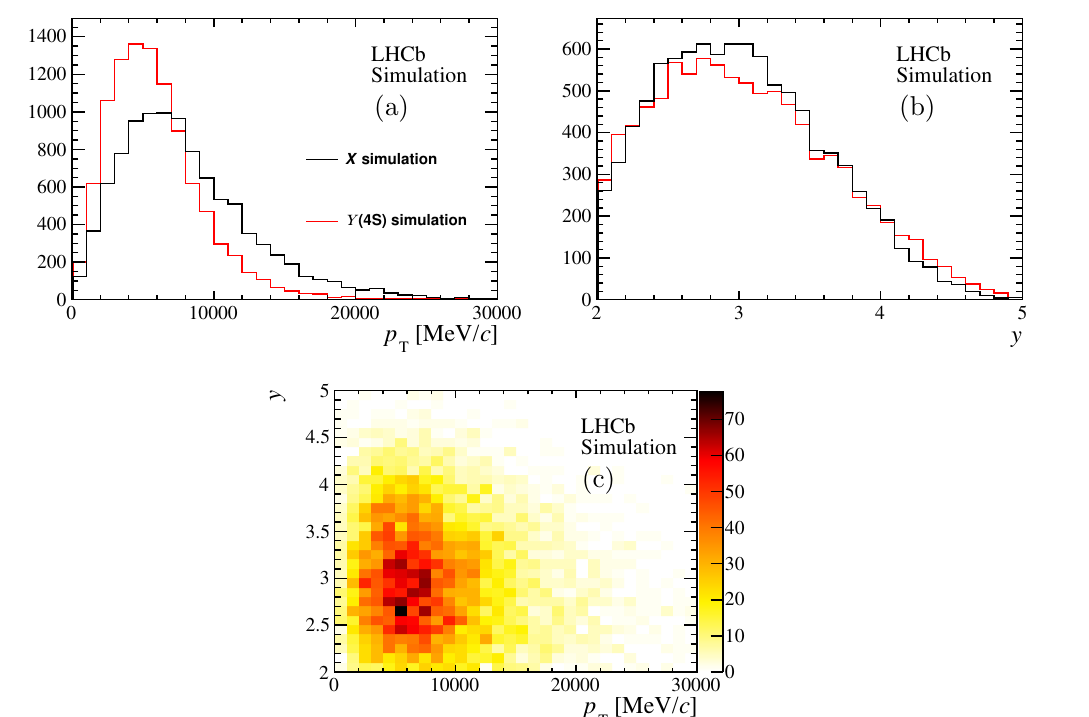
Figure 5 . The kinematic distribution of (black) simulated X particles in (a) p T and (b) rapidity, and (c) the 2D distribution. For comparison, the kinematic distribution of (red) simulated (cid:7) (4 S ) particles is also shown.